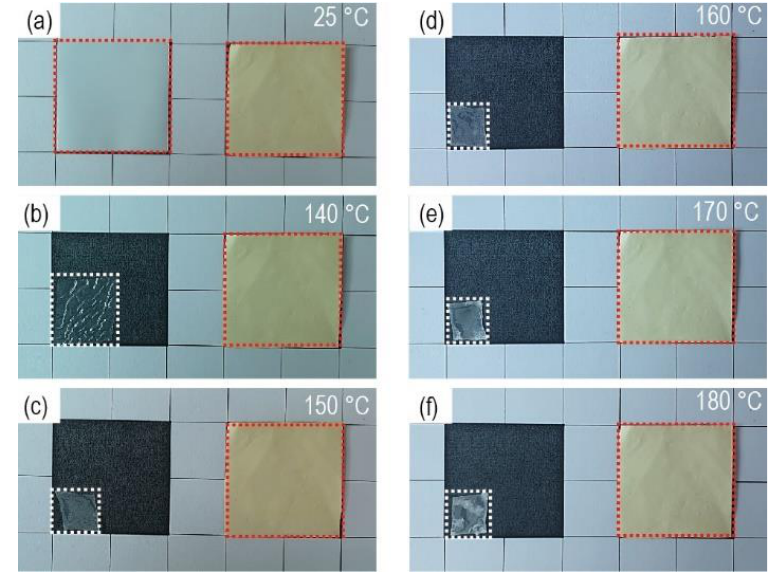
Figure 4. Dimensional changes of the separators (original size = 3 × 3 cm) exposed to different temperatures of ( a ) 25 °C, ( b ) 140 °C, ( c ) 150 °C, ( d ) 160 °C, ( e ) 170 °C, and ( f ) 180 °C (left = bare PE separators, right = porous PI separators).